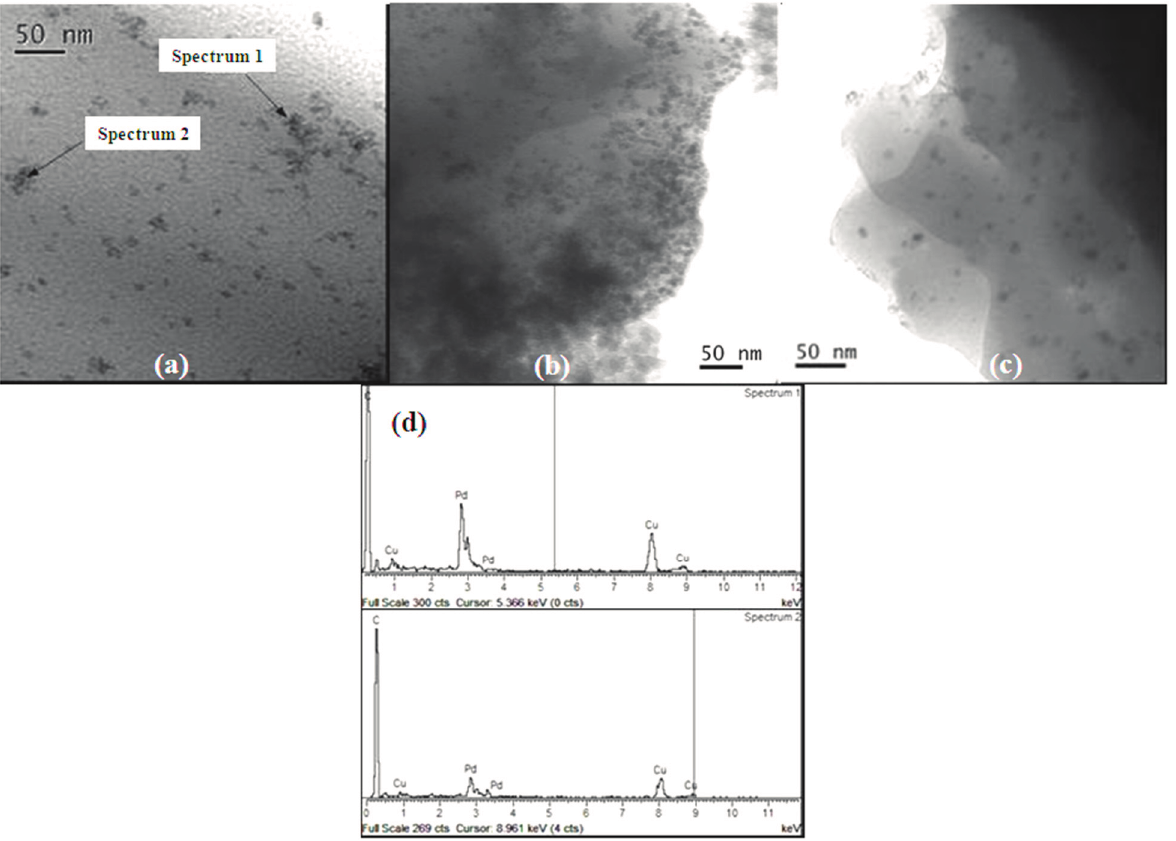
Figure 4. TEM bright field images of Pd-pol after ( a ) 30 min; ( b ) the first cycle; and ( c ) the fifth cycle of the Suzuki-Miyaura cross-coupling reaction described in entry 1 of Table 1; ( d ) EDS specta of selected areas of ( a